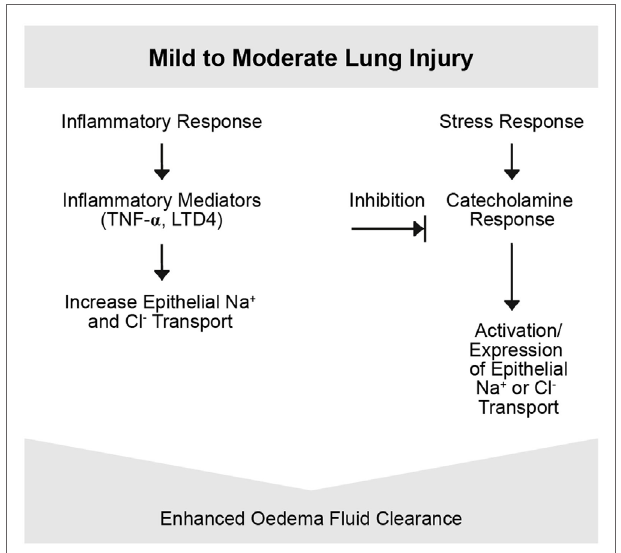
FigURe 3 | Mild-to-moderate lung injury. Mild-to-moderate lung injury may lead to enhanced edema clearance. This response is due to an activation of epithelial Na + transport probably based on the increased endogenous catecholamine production associated with the insult. However, in certain types of injury, other pathways may be involved. Other inflammatory mediators such as tumor necrosis factor (TNF) potentially participate